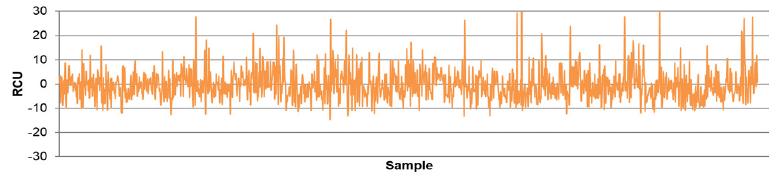
Figure A33. Prediction error of NN2 model training dataset.